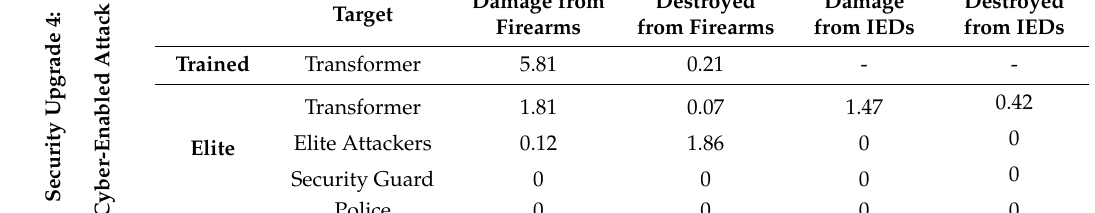
Table 5. Security Upgrade 4: Cyber-Enabled Attack.